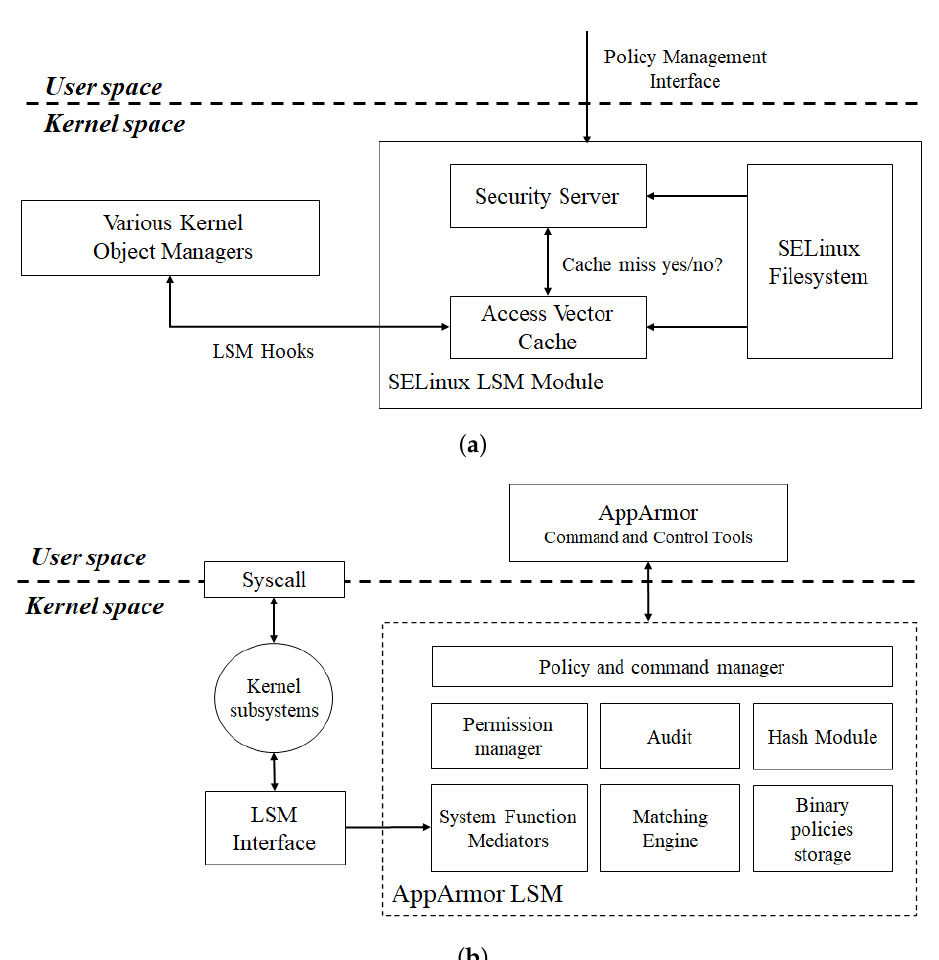
Figure 3. File access control structures: ( a ) SELinux registers the access control policy at the security server in the kernel and enforces it with the access vector cache. ( b ) AppArmor registers the access control policy using command and control tools and enforces it with system function mediators